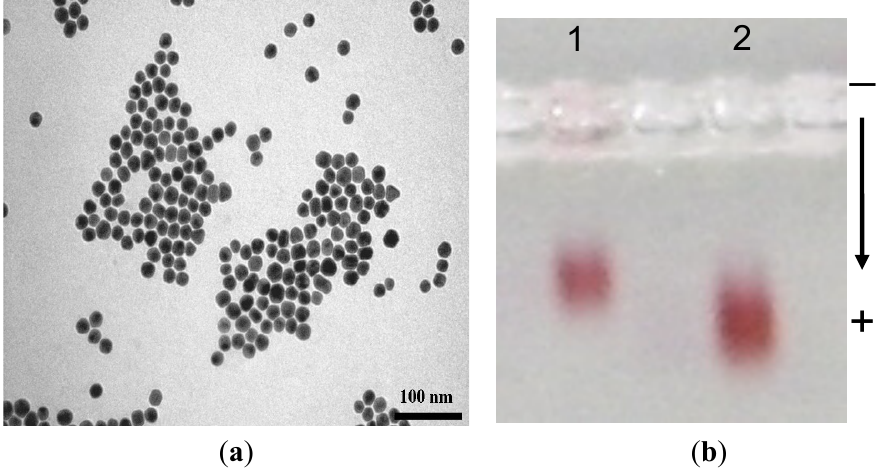
Figure 4. ( a ) The TEM micrograph of the streptavidin gold conjugates (at 100 nm scale) and ( b ) agarose gel electrophoresis measurements of streptavidin gold bioconjugates, showing the mobilities of lane 1: streptavidin gold conjugates and lane 2: PEG-biotin